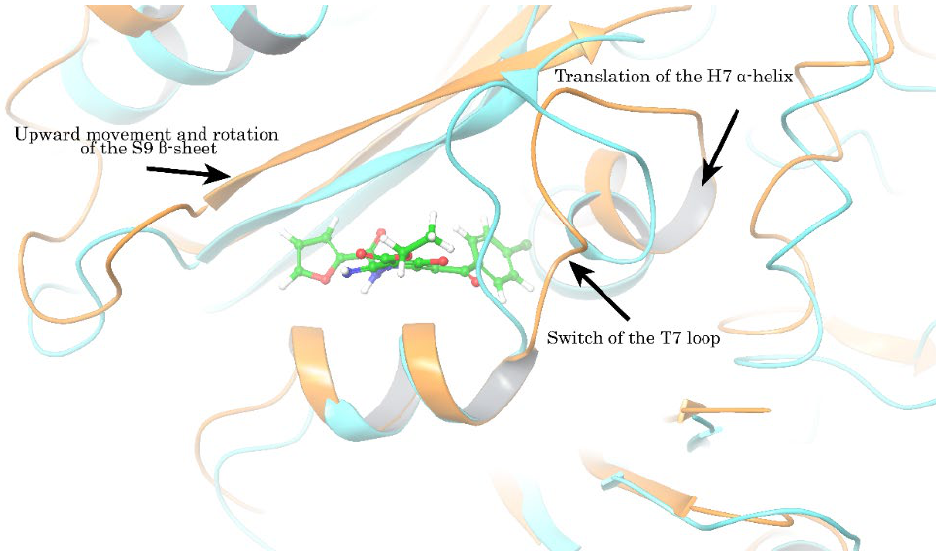
Figure 11. The structural difference between straight (PDB ID: 1JFF) and representative conformations of β -chain of tubulin was obtained from MD. The straight conformation (light brown color) of the β -chain of tubulin is aligned with the representative conformation (blue color). Arrows indicate the main secondary elements undergoing significant structural changes during the transition from one conformation to another. The straight confirmation is not suitable for interaction with the EAPC-67, since steric clusters are formed with the amino acids of the protein secondary elements (S8, S9, H7, T7) surrounding the colchicine-binding pocket.